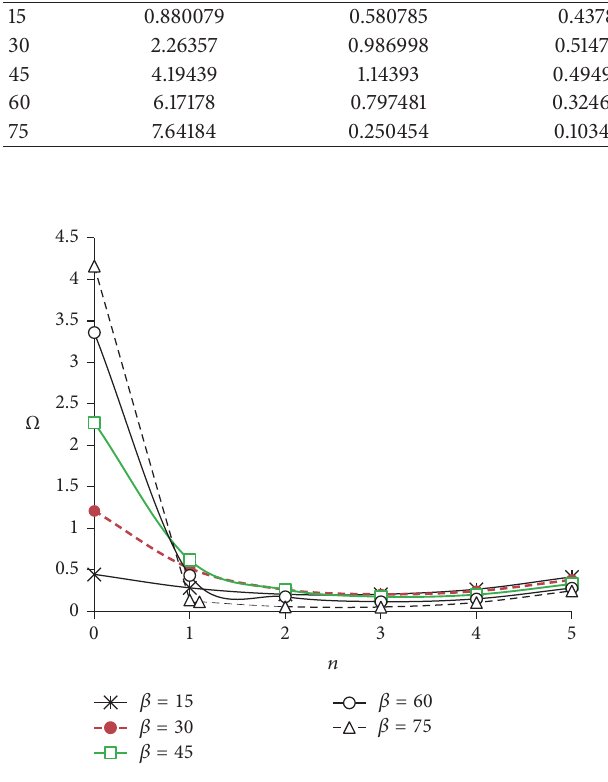
Figure 3: Nondimensional frequency variation of fixed PMMA/ CNT composite shell for 𝑉 ∗ CN = 0.12 .